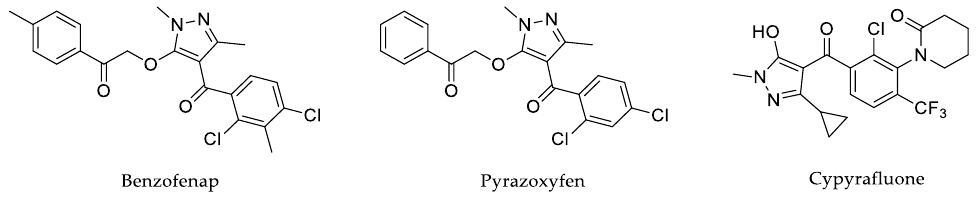
Figure 2. Structures of commercial herbicides containing pyrazoles.